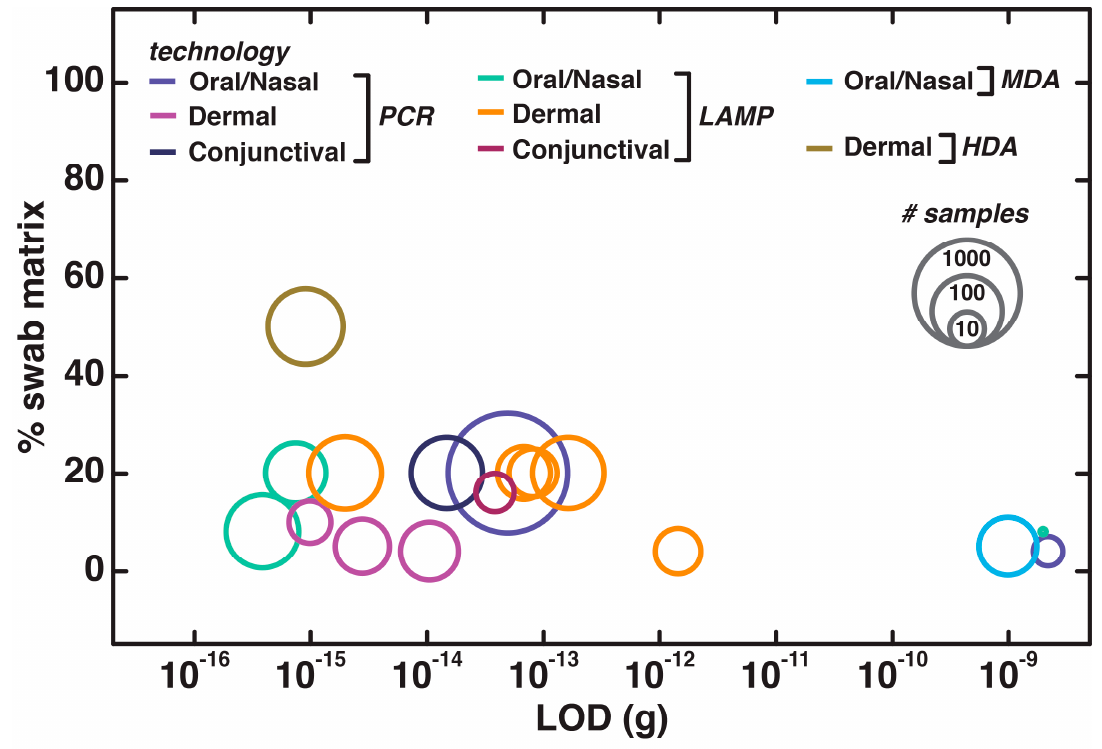
Figure 7. Swab-based procedures for nucleic acid testing, with data presented as in Figure 3.